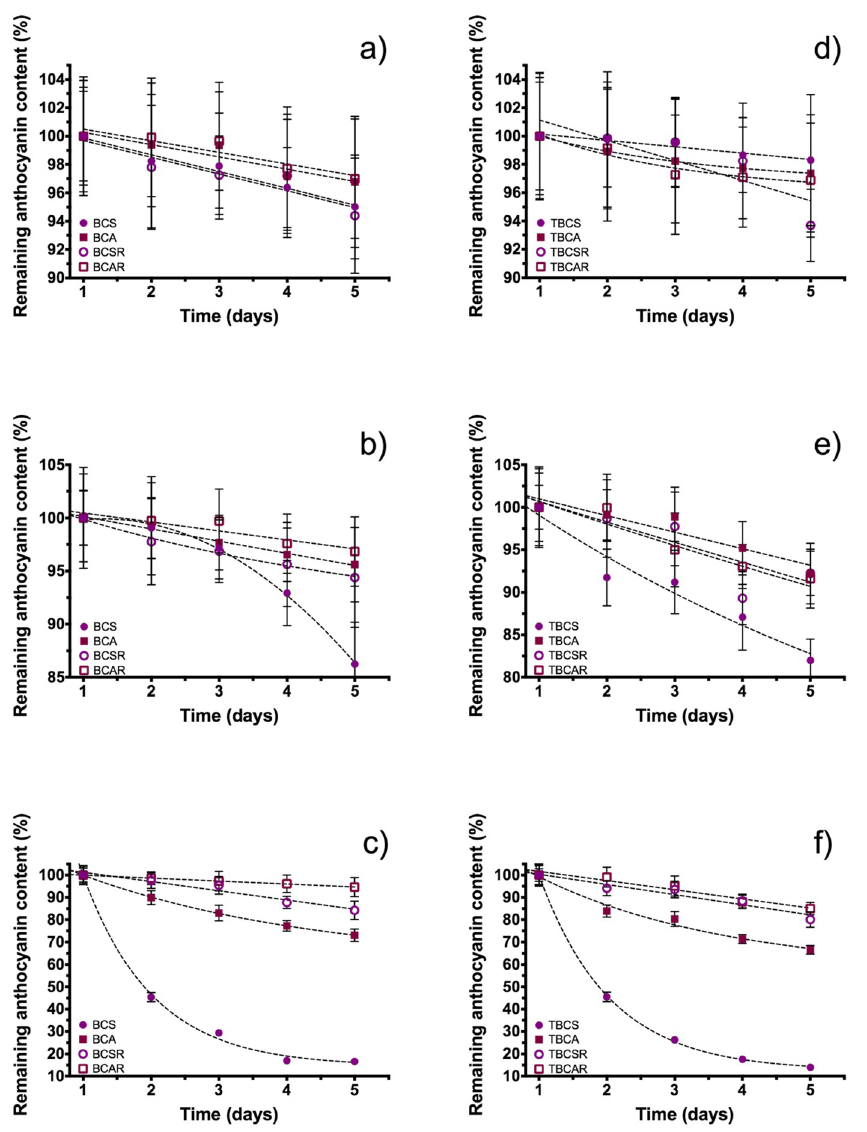
Figure 6. Anthocyanin content as function of storage time at different pH buffers; ( a , d ) pH = 4, ( b , e ) pH = 7 and ( c , f ) pH = 10. Samples extracted with ethanol/citric acid (BCS) and ethanol/acetic acid (BCA), samples after resin column (BCSR and BCAR), and microencapsulated samples using TEOS (TBCS, TBCA, TBCSR, TBCAR).